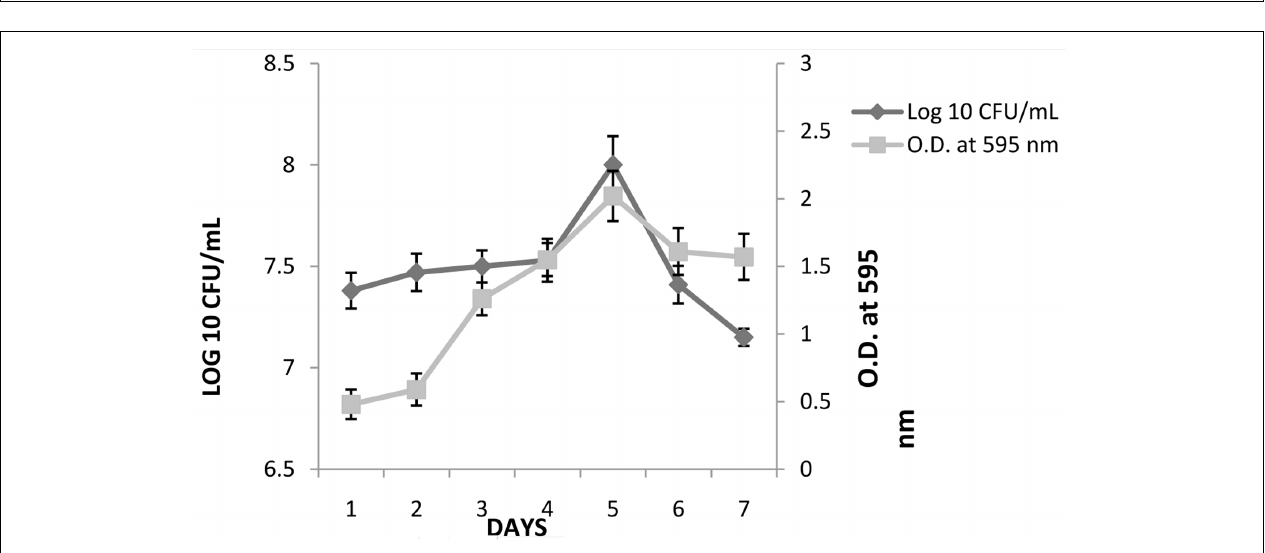
FIGURE 1 | (A,B) Are representative pictures of Congo red agar plates in which blackening was observed confirming the EPS production by K. pneumoniae . (C,D) Show less black colonies on agar plates containing 0.9 mg per ml of H-AgNPs, decreased EPS production by K. pneumoniae.